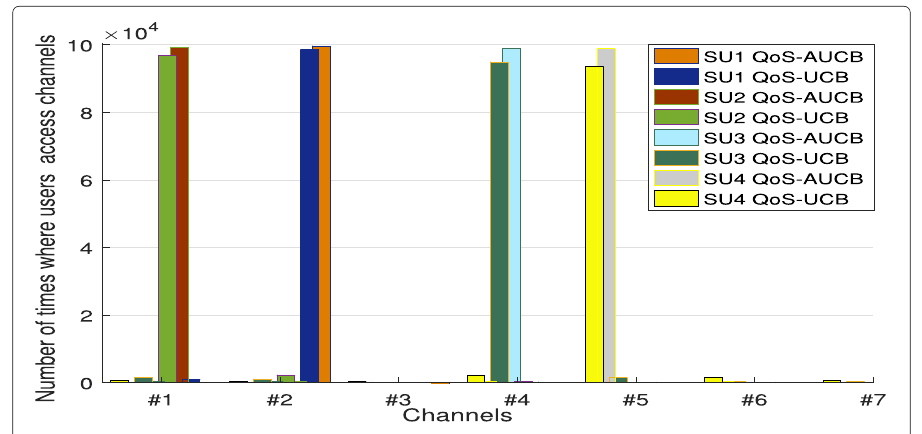
Fig. 9 Access channels by the priority users using QoS-AUCB and